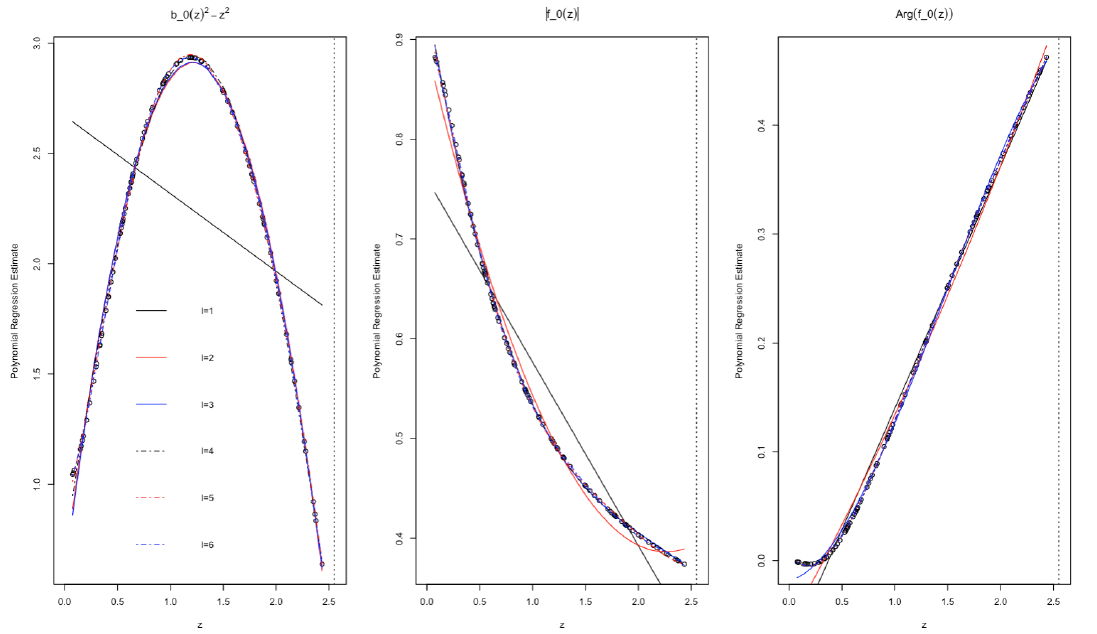
Figure 3. The estimates of critical collapse functions based on a polynomial regression method of orders l = { 1, . . . ,6 } in elliptic case based on a training sample of size n = 100.